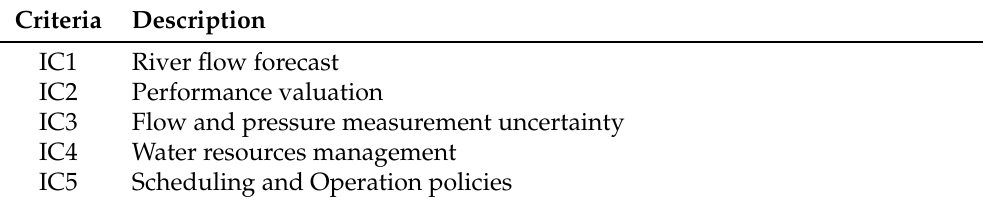
Table 2. Inclusion